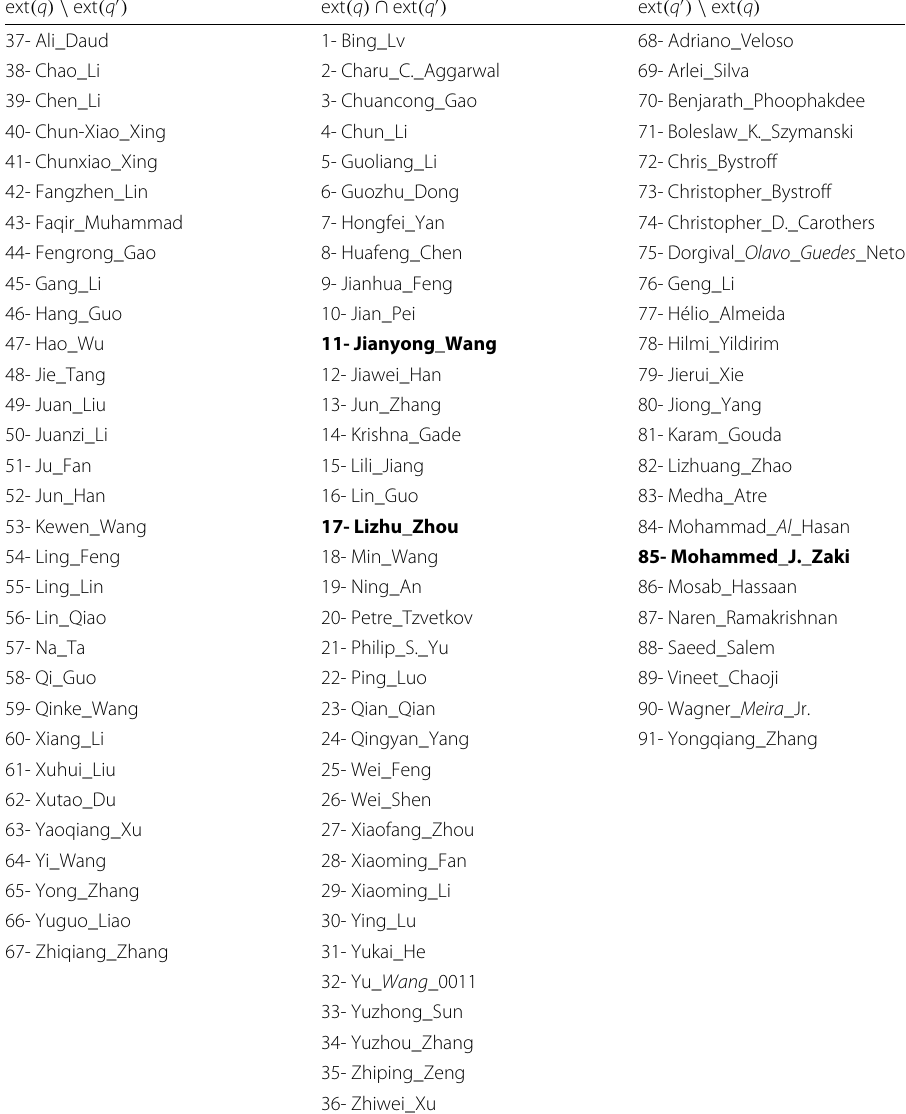
Table 4 Authors from the DBLPE dataset and their index as it appears on the core subgraphs of the bi-patterns q and q (cid:2) depicted on the left and right part of Fig.